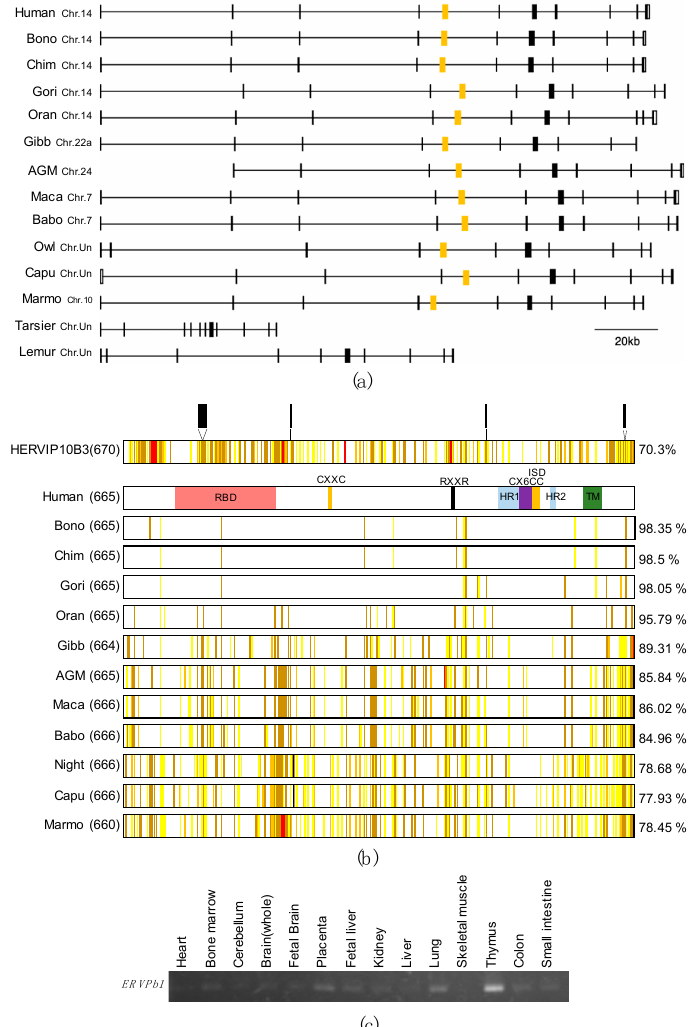
Figure 1. ERVPb1 is conserved in Simiiformes and its mRNA expression is observed in human tissues. ( a ) Location of the conserved ERVPb1 between RIN3 exons 4 and 5 in Simiiformes including three Platyrrhini species. The orange and black colored boxes represent the ERVPb1 locus and RIN3 exons, respectively. Bono: Bonobo, Chim: Chimpanzee, Gori: Gorilla, Oran: Orangutan, Gibb: Gibbon, AGM: African green monkey, Maca: Macaca, Babo: Baboon, Owl: Ma’s night monkey, Capu: Capuchin, Marmo: Marmoset, Tarsier: Philippine tarsier, Lemur: Greater bamboo lemur. ( b ) The putative ERVPb1 ORFs found in Simiiformes and HERVIP10B3 ENV (upper line). The numbers in the parentheses and those on the right side indicate the number of amino acids and% identity to the human ORF, respectively. The black and red bars indicate insertion and deletion, respectively. The colored bars indicate conservation between groups of strongly similar (roughly equivalent to scoring > 0.5 in the Gonnet PAM 250 matrix: yellow) or weakly similar (roughly equivalent to scoring < 0.5 and > 0 in the Gonnet PAM 250 matrix: orange) properties, or that they are not similar (brown) to the human ORF. The colored boxes in the human ORF indicate ERVPb1 motifs and domains, such as CXXC and CX6CC: disulfide-bond isomerase motifs, HR1 and HR2: heptad repeats, ISD: immunosuppressive domain, RBD: receptor binding domain, RXXR: furin cleavage site, and TM: transmembrane domain. ( c ) ERVPb1 transcripts detected by RT-PCR (270 bp) in human tissues. Thirty-five cycles of the PCR reaction were performed.